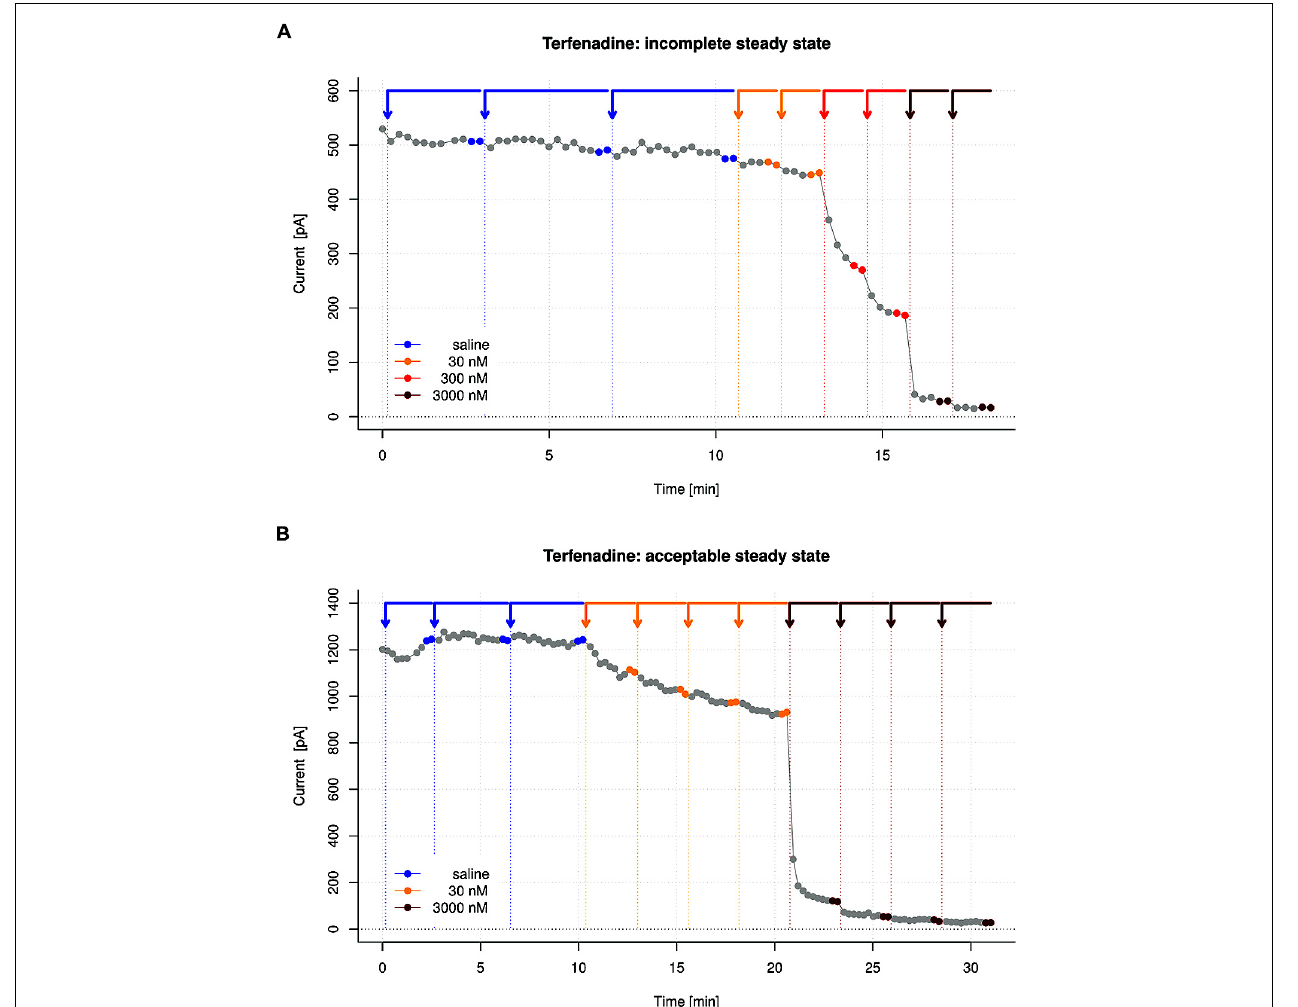
FIGURE 6 | Good and bad practice examples for steady state of drug induced block byTerfenadine. (A) Bad practice example of an I/t plot showing insufficient steady state of block, which would lead to